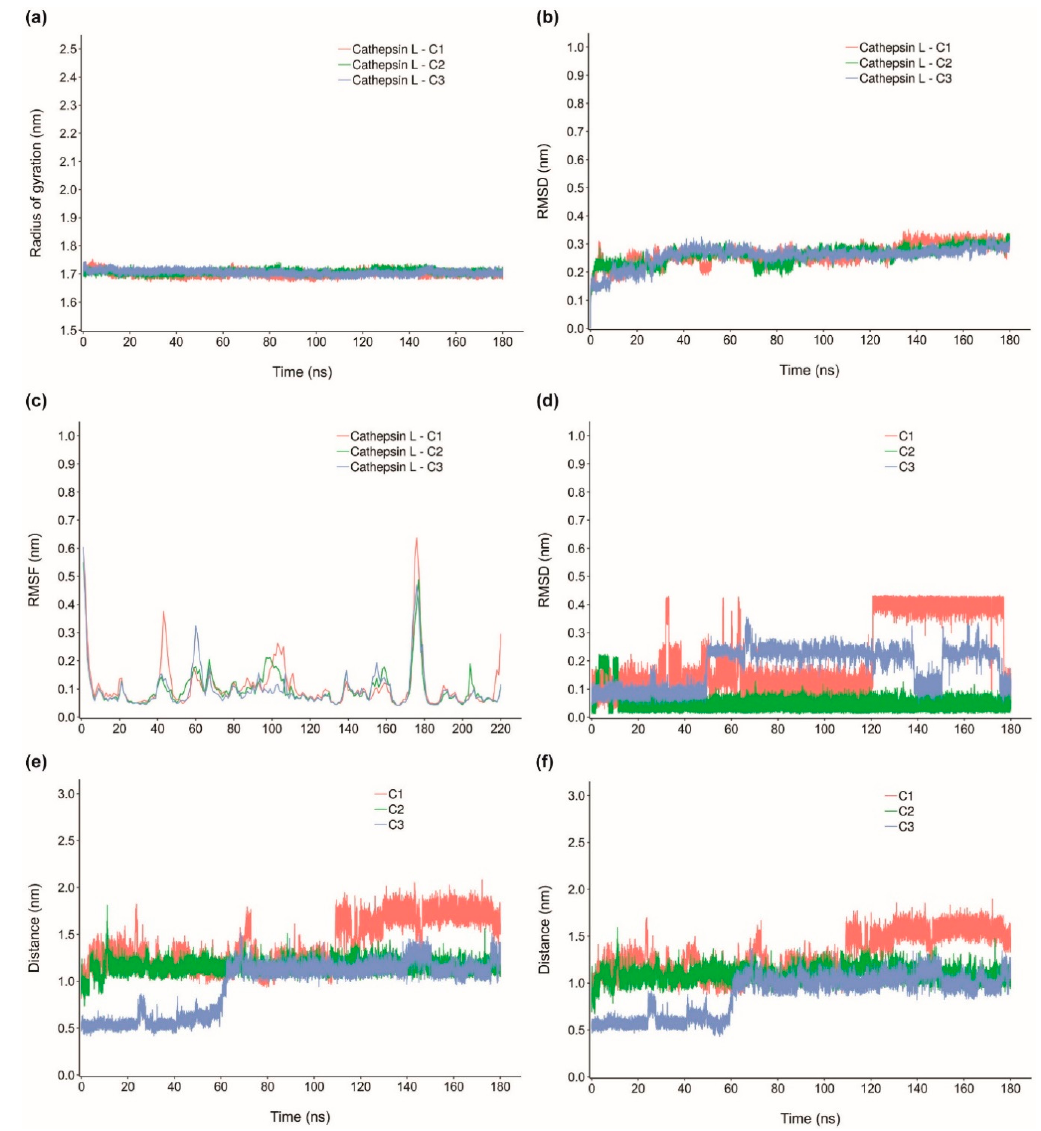
Figure 9. ( a ) Radius of gyration for cathepsin L in complex with C1, C2 and C3, ( b ) RMSD for cathepsin L in complex with C1, C2 and C3, ( c ) RMSF for cathepsin L in complex with C1, C2 and C3, ( d ) RMSD of C1, C2 and C3, ( e ) Distance of the center of mass of C1, C2 and C3 from the catalytic residue C25 in cathepsin L, and ( f ) Distance of the center of mass of C1, C2 and C3 from the catalytic residue H163 in cathepsin